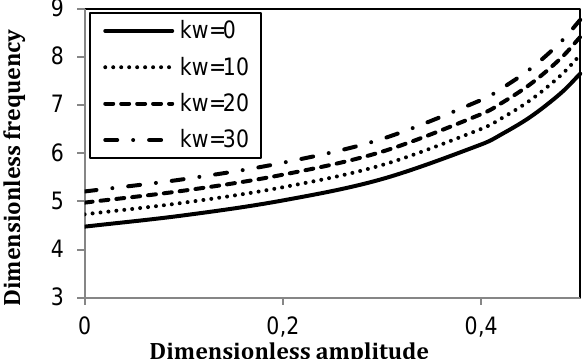
Figure 6: Dimensionless frequency vs. dimensionless amplitude for different foundation parameter values. ( L / h = 10 , V = 5 , K p = 20 , ∆T = 20 ∘ , α = 0.5 )